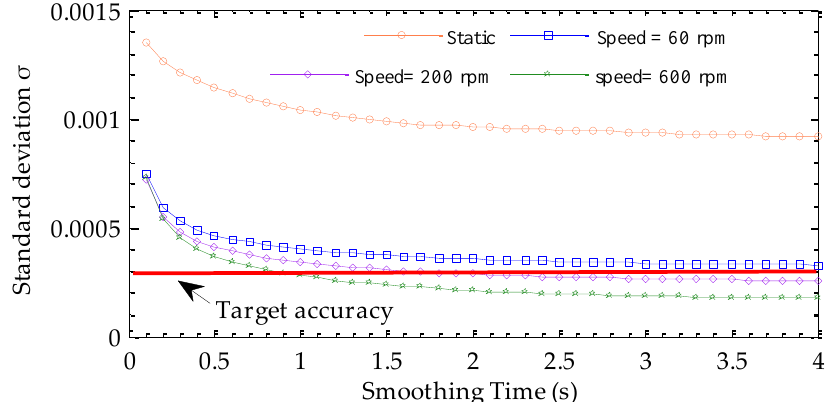
Figure 10. The improved system configuration. The green box represents the thermal control function, and a vibration motor is installed behind the telescope.